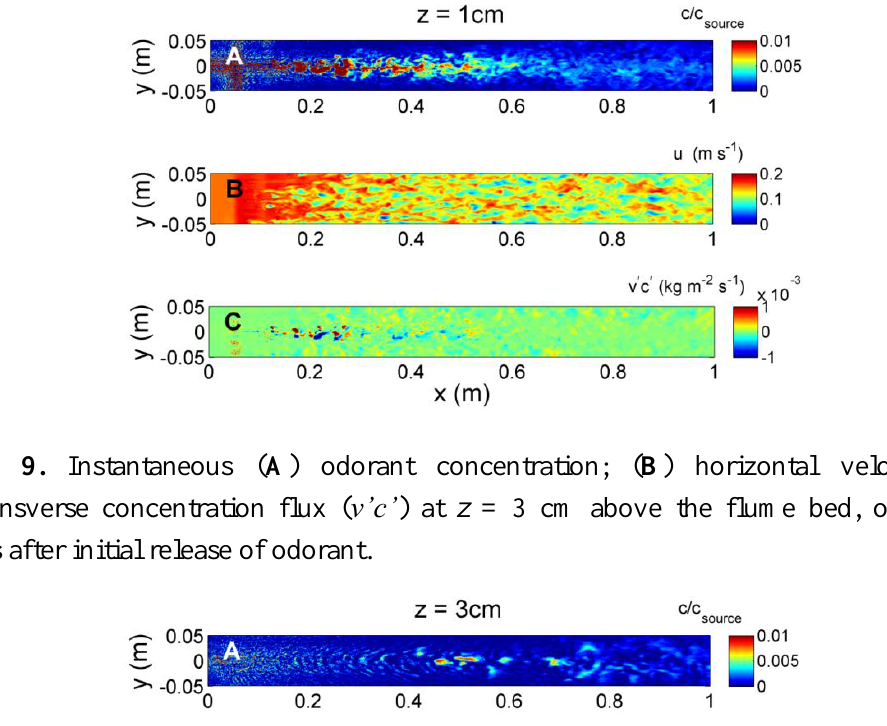
Figure 8. Instantaneous ( A ) odorant concentration; ( B ) horizontal velocity; and ( C ) transverse concentration flux ( v’c’ ) at z = 1 cm above the flume bed, obtained at t = 10 s after initial release of odorant.